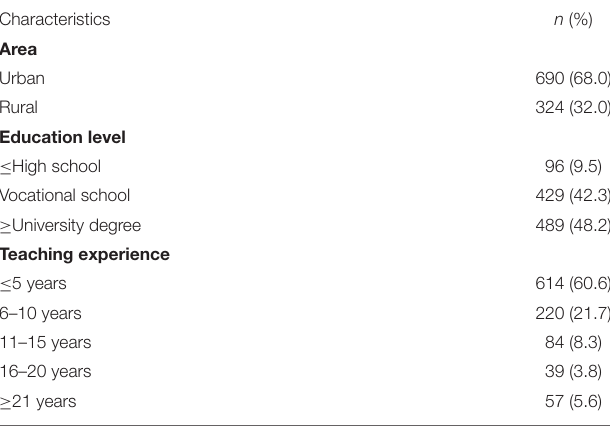
TABLE 1 | Demographic information of kindergarten teacher sample ( n =